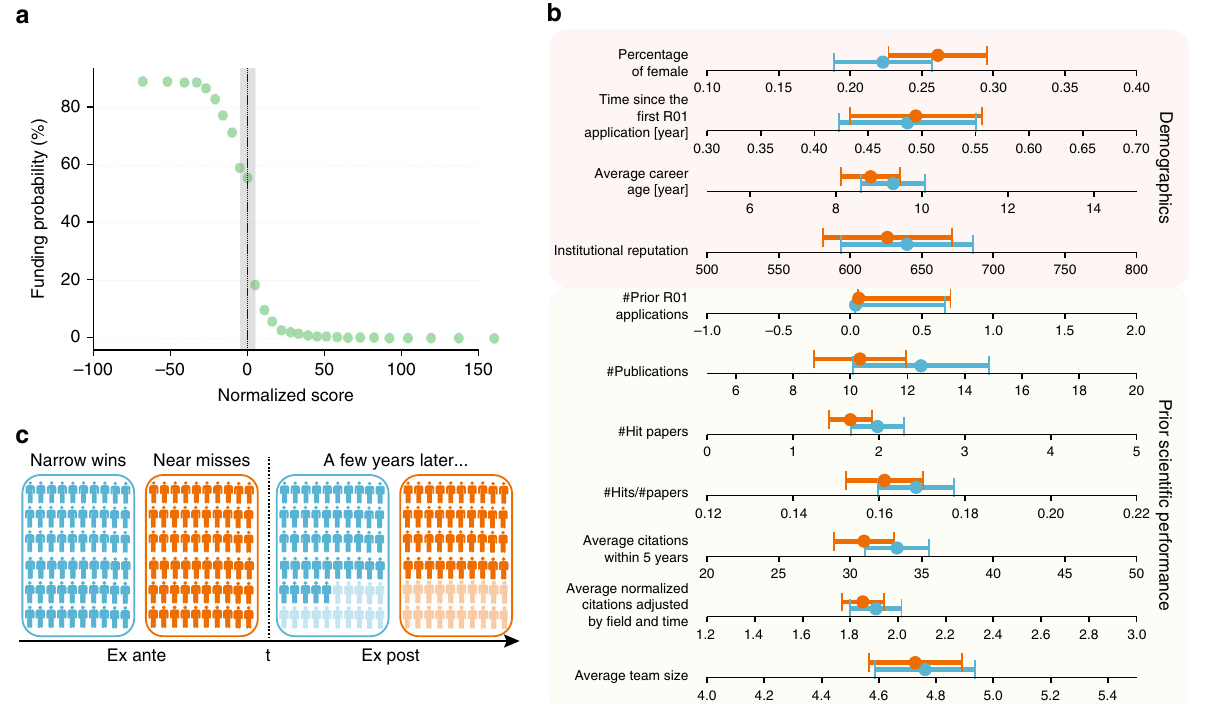
Fig. 1 Pre-treatment comparisons between the narrow-win and near-miss applicants. a Relationship between normalized score and award status. Funding probability shows a clear transition around the funding threshold. We focus only on junior PIs whose normalized scores lie within the range ( − 5, 5), the shaded gray area, which includes 561 narrow-win and 623 near-miss applicants in our sample. b Pre-treatment feature comparisons between the near-miss and narrow-win group. We compared 11 different demographic and performance characteristics. The features are de fi ned as follows (from top to bottom): (1) percentage of female applicants; (2) number of years since the fi rst R01 application; (3) number of years since the fi rst publication; (4) institutional reputation, measured by the number of R01 grants awarded to an institution between 1990 to 2005; (5) number of previous R01 applications; (6) number of publications prior to treatment; (7) number of prior papers that landed within the top 5% of citations within the same fi eld and year; (8) probability of publishing a hit paper; (9) average citations papers received within 5 years of publication; (10) citations normalized by fi eld and time; 34 and (11) average team size across prior papers. We see no signi fi cant difference between the two groups across any dimension we measured; Error bar represents the 95% con fi dence interval. c An illustrative example of the underlying process. Solid color indicates people who remained active, whereas shaded color denotes the fraction that disappeared from the NIH system. Blue and orange indicate narrow-win and near-miss applicants,